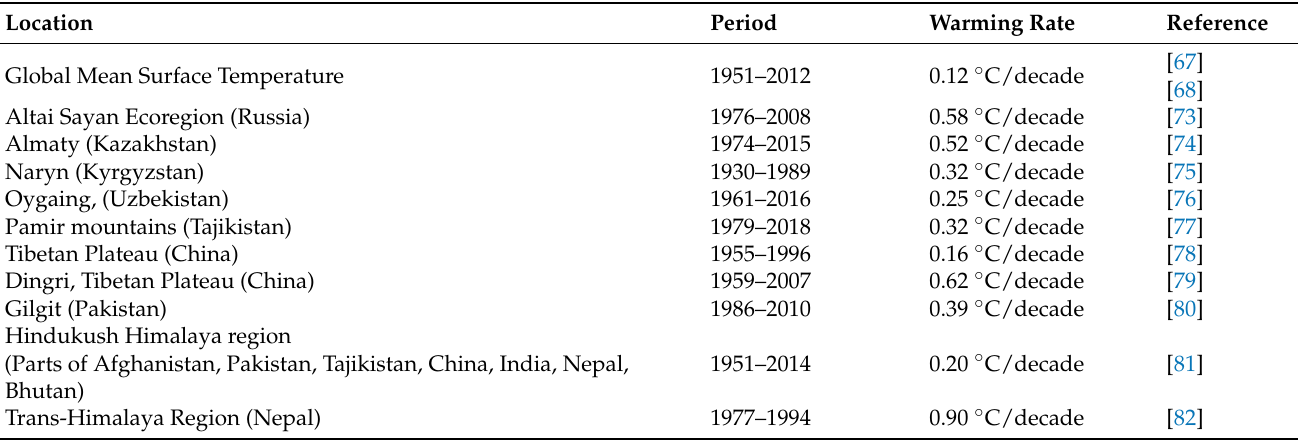
Table 2. Climate warming rates from the selected sources in the snow leopard landscape (listed from north to